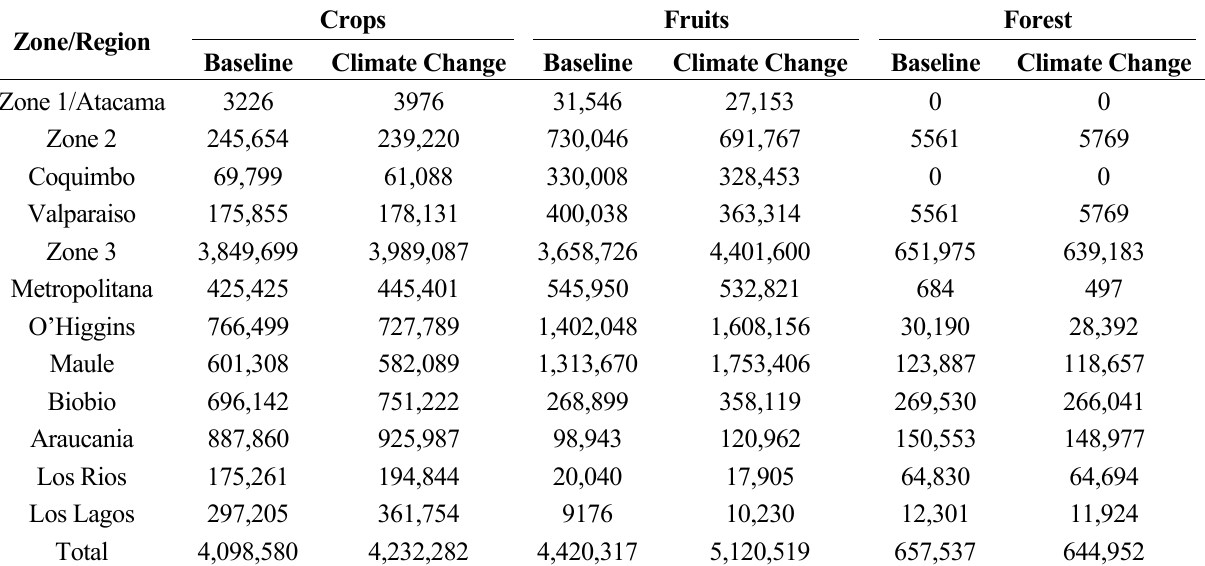
Table 1. Agricultural Production by Region and Activity Type